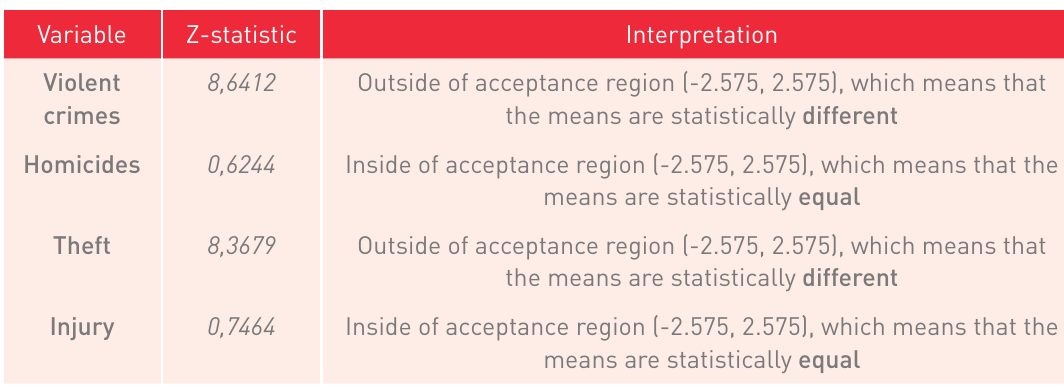
Results of the Z- test for the Brumadinho dataset